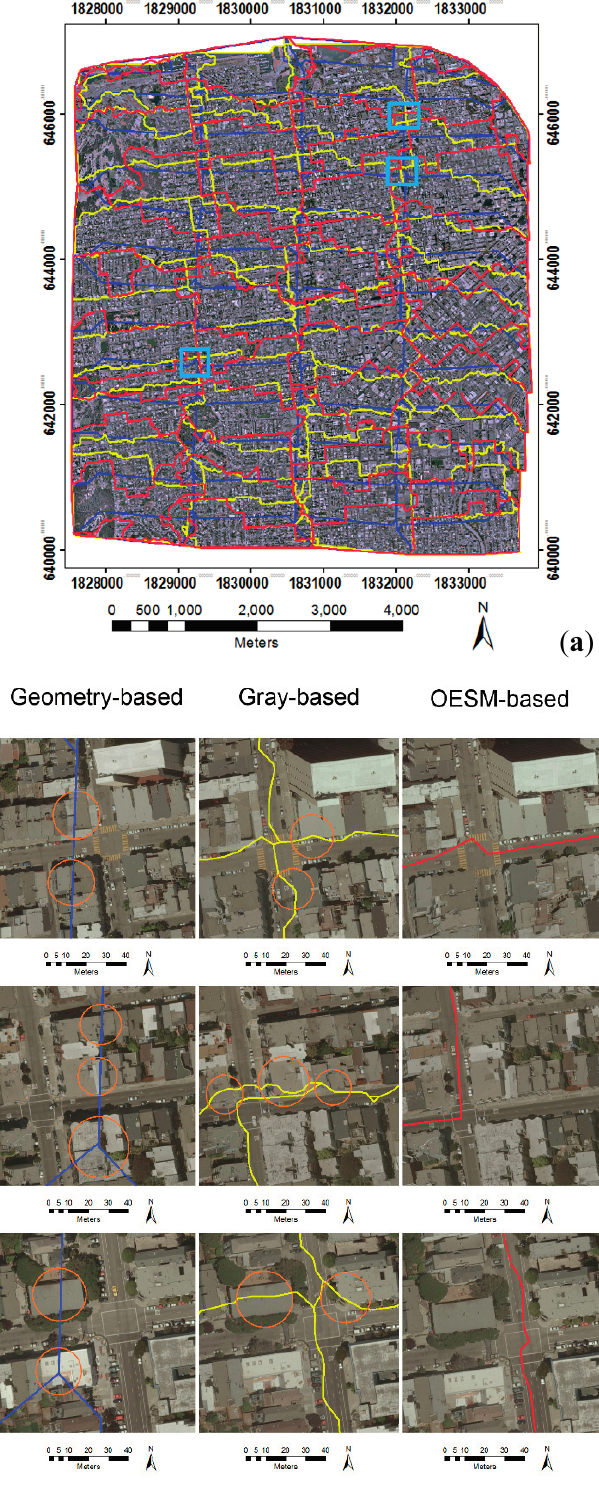
Figure 13. Mosaic results of the three methods for Dataset 3. ( a ) Overview of the mosaicked images. The blue lines are the seamlines constructed through the geometry-based method; the yellow lines are the seamlines constructed through the gray-based method; and the red lines are the seamlines constructed through the OESM-based method. ( b ) Detailed seamlines in the cyan rectangular areas of (a) selected through the three methods. The orange circle marks the visual continuities from the